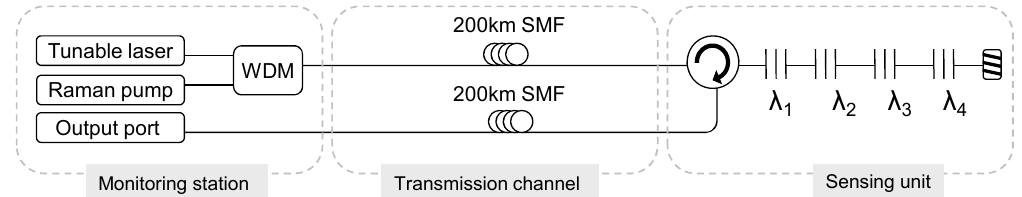
Figure 10. Schematic depiction of the ultra-long fiber Bragg grating sensor system [69].